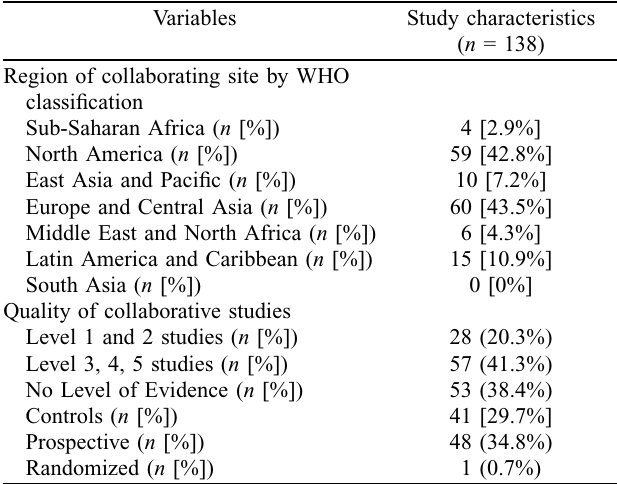
Table 4. Characteristics of collaborative global orthopaedic studies from 2004 to